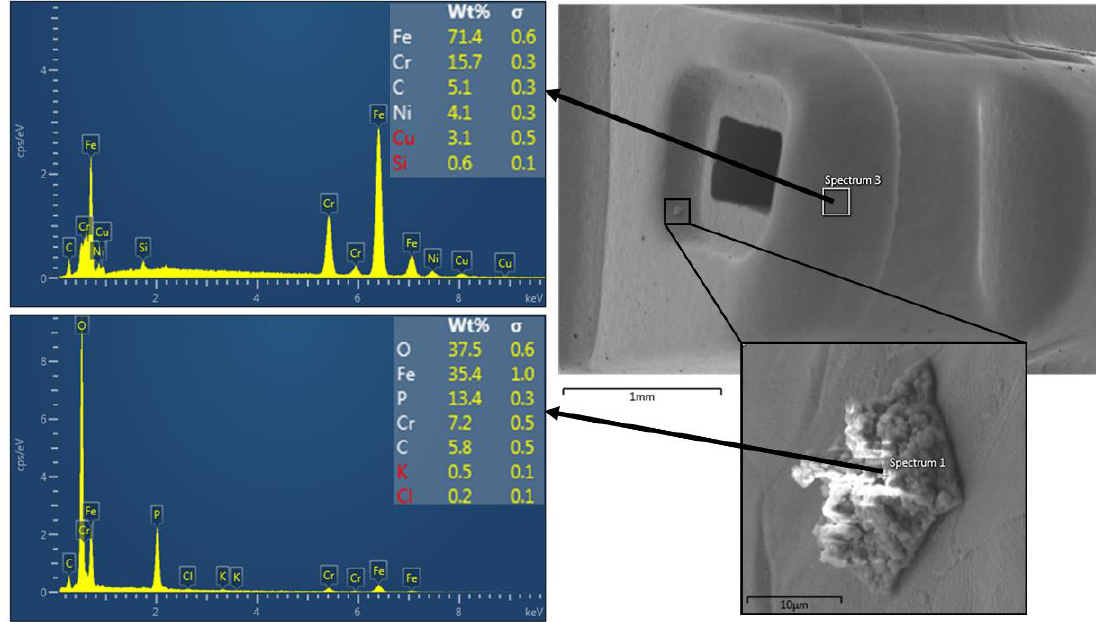
Figure 4. SEM surface micrographs and EDS analysis of tubes after the corrosion test at pH = 2.3.